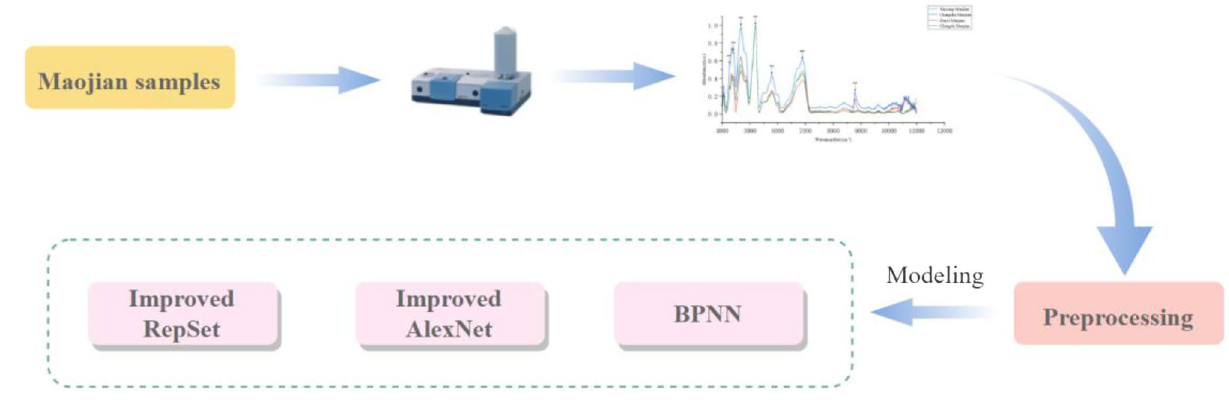
Figure 1. The overall work flow chart.